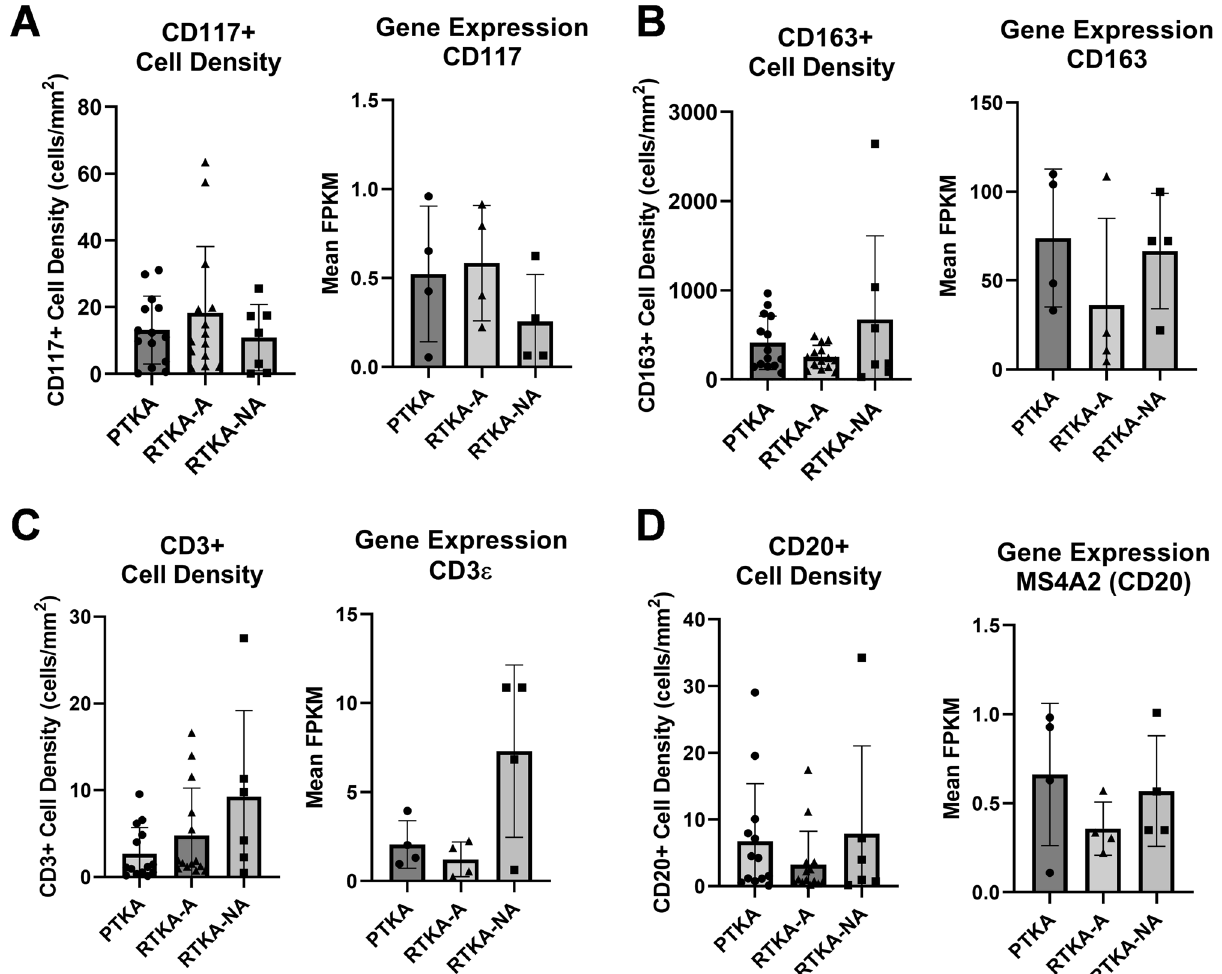
Figure 9. Correlation between immune cell numbers and gene expression in periarticular knee tissue. Tissue density of CD117 + mast cells ( A ), CD163 + macrophages ( B ), CD3 + T-cells ( C ), and CD20 + B-cells ( D )